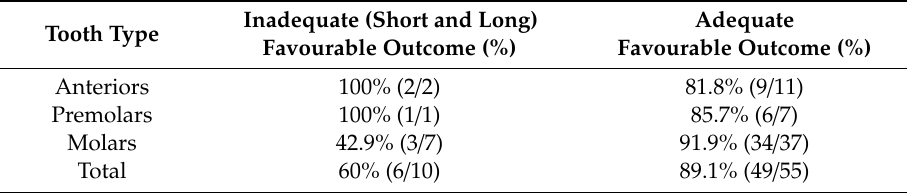
Table 3. E ff ect of apical extension of root filling assessed on CBCT images on root canal treatment